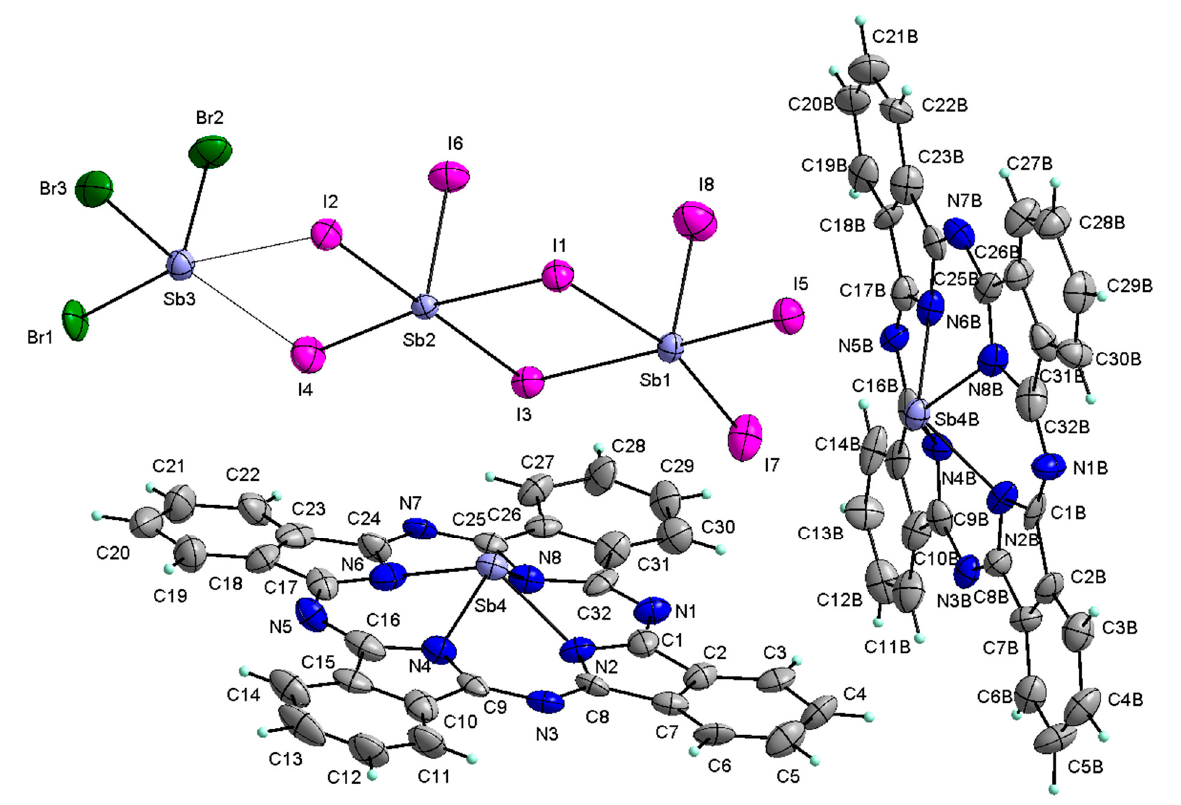
Figure 1. Asymmetric unit of 1 showing two independent (SbPc) + units and (Sb 3 I 8 Br 3 ) 2 − .